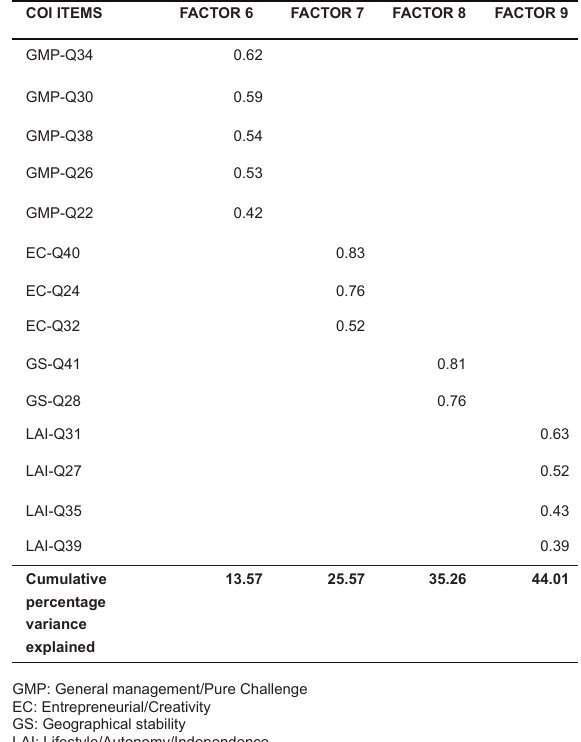
TABLE 2 EFA rotated factor matrix: Principal axis factoring with varimax rotation section 2-agreement